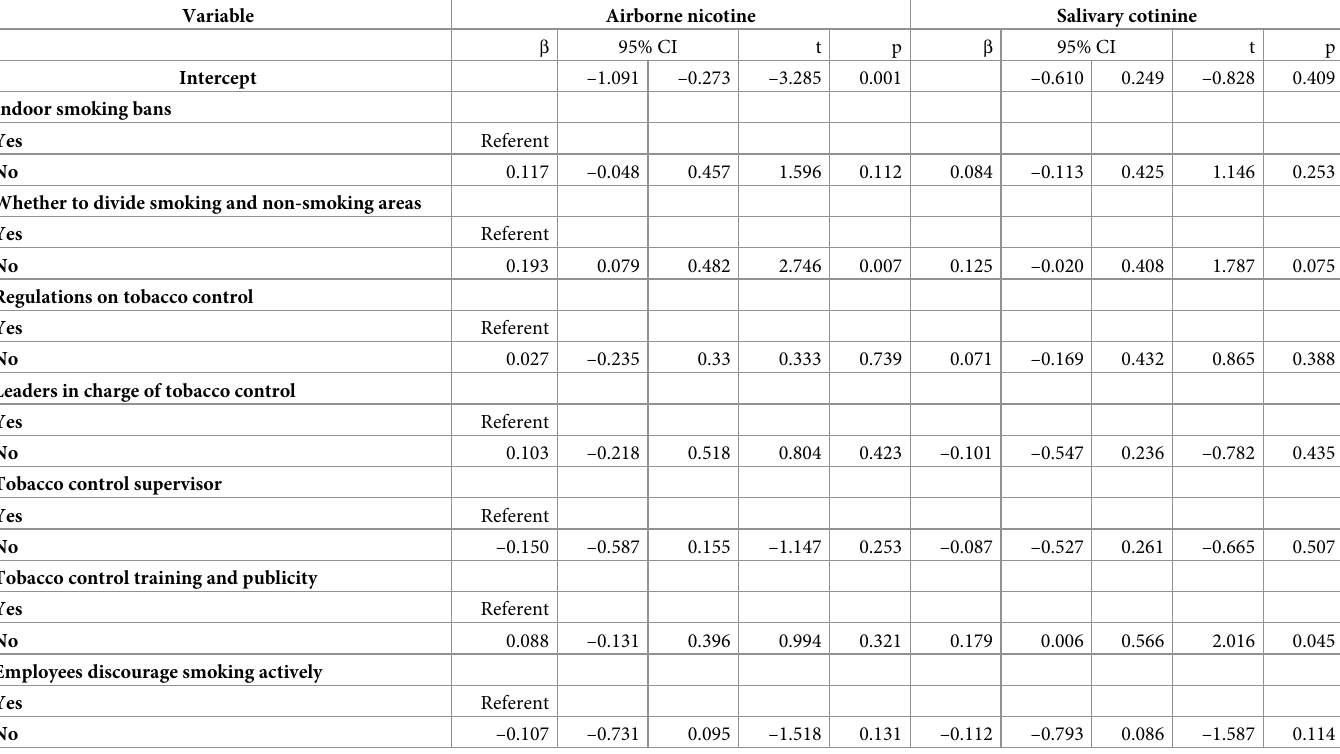
Table 3. Multivariate linear regression analysis of smoke-free measures in workplaces associated with airborne nicotine and salivary cotinine concentration (N = 222).